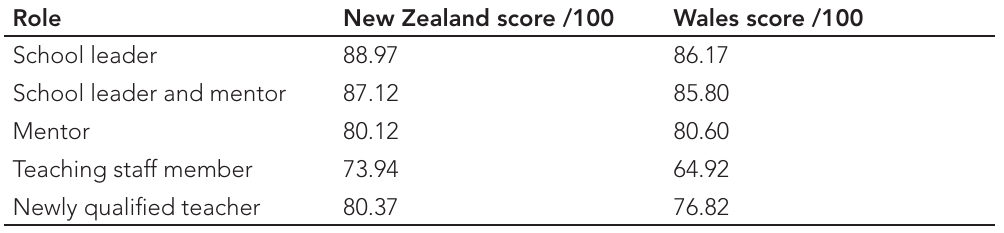
Table 2. Mean Total LIMS Scores by Position for New Zealand and Wales Participants